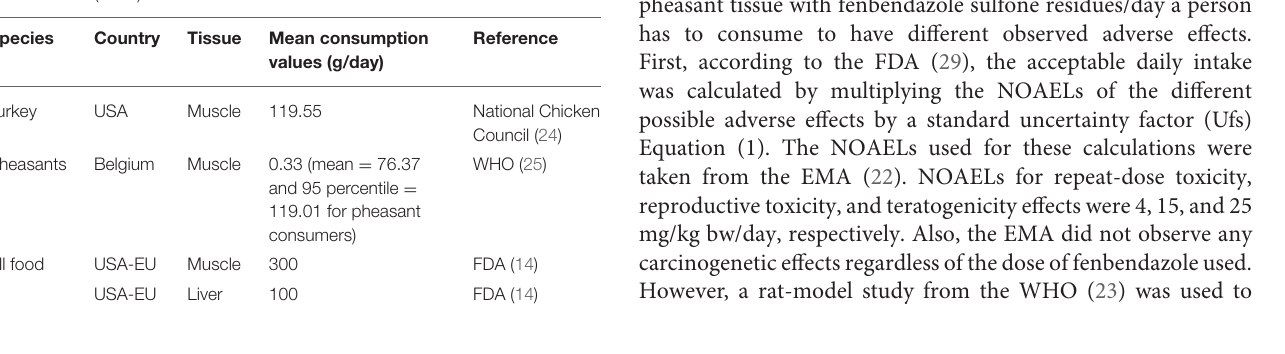
TABLE 1 | Turkey meat consumption data in USA (2019), pheasant fresh meat consumption data in Belgium (2004), and FDA/EMA food consumption values for edible tissues (2018).